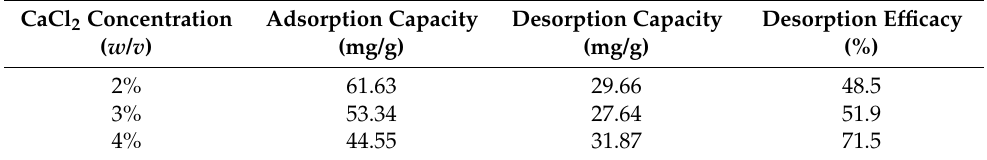
Table 3. Summarized toluene adsorption–desorption capacity depending on CaCl 2 concentration.